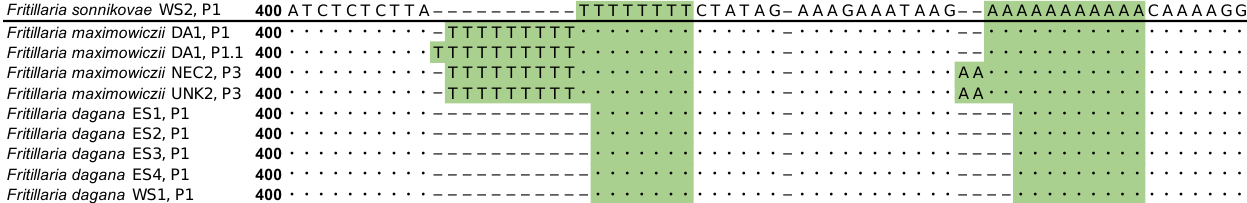
Figure 5. The fragment of the rps16 multiple alignment for three closely related Fritillaria species. The dots indicate bases same as in the reference sequence ( F. sonnikovae ), characters indicate the differences, the dashes indicate the gaps, and the numbers indicate positions in the alignment. The polymorphic poly(A) and one poly(T) regions mentioned in the text are shown in light green.